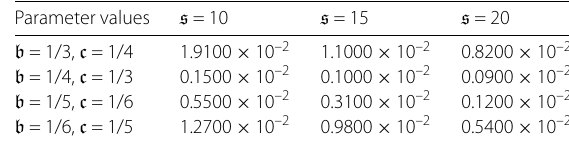
Table 3 Absolute error in boundary conditions of x ( t ) of Example 6.3 for different values of parameters b and c